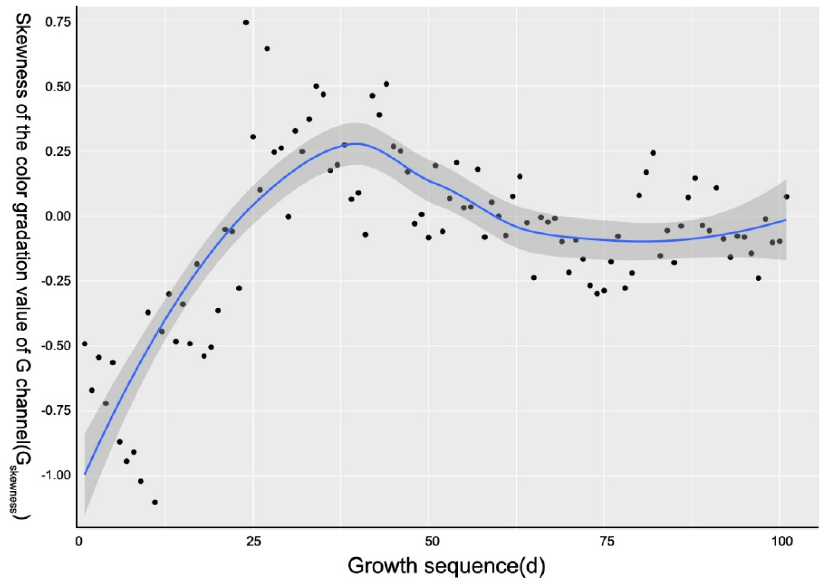
Figure 7. Scatter plot of G Skewness during the whole growth period of pepper. G Skewness was fitted by the local polynomial regression-fitting algorithm, which was implemented by the geom_smooth function of R. X axis was the sequence of daily leaf age, and Y axis was the daily value of G Skewness .